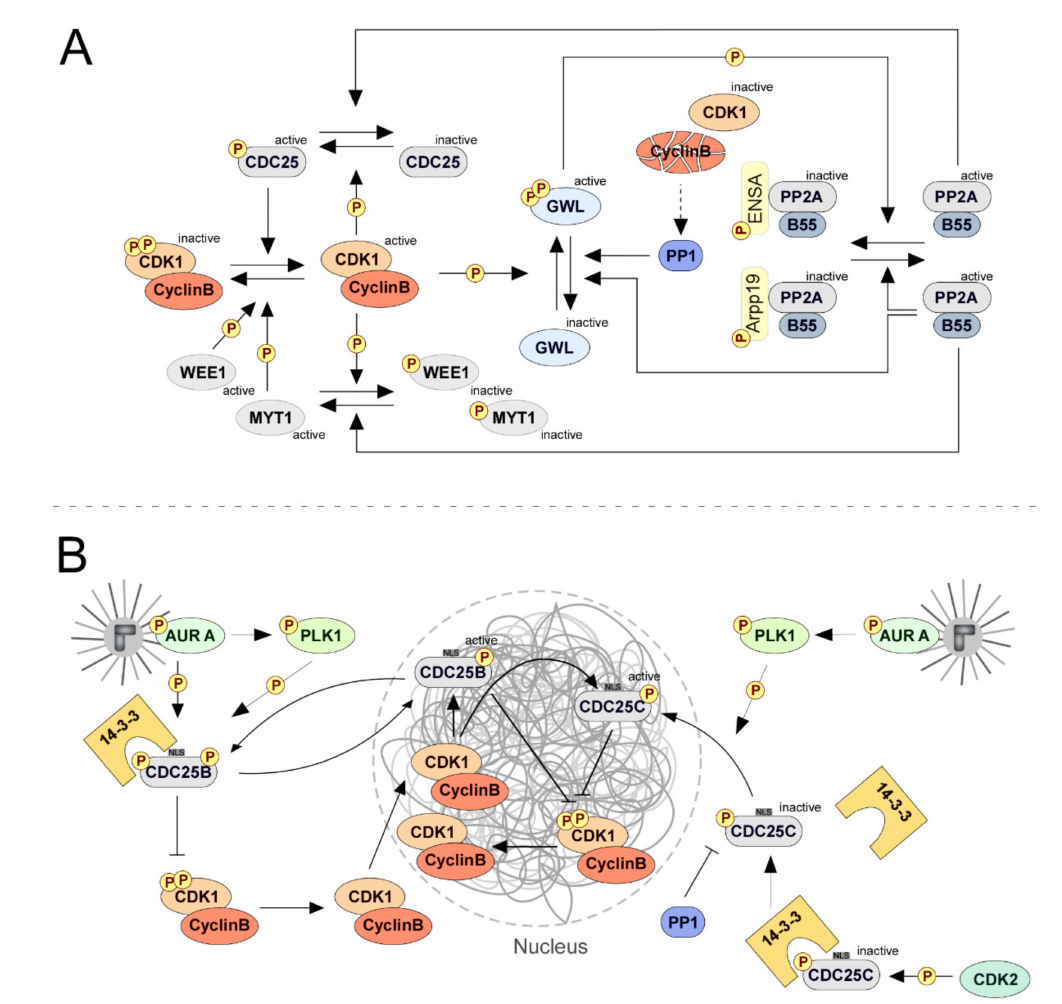
Figure 3. Molecular circuitry controlling mitotic entry. ( A ) CDC25 phosphatases dephosphorylate and activate CDK1-Cyclin B to promote mitotic entry. CDC25 activity antagonizes the inhibitory phosphorylations on CDK1 (Thr14 and Tyr15) catalyzed by MYT1 and WEE1. Active CDK1-Cyclin B respectively inhibits and promotes MYT1/WEE1 and CDC25 activities, establishing both a double negative feedback loop and a positive feedback loop. This regulatory circuitry defines a bistable trigger that ensures irreversible transition into mitosis. CDK1-Cyclin B further promotes the activation of GWL kinase, which subsequently phosphorylates ENSA and Arpp19. The phosphorylated forms of these endosulfines bind to PP2A-B55 and inhibit the phosphatase activity towards CDK1-Cyclin B substrates, including MYT1, WEE1, and CDC25. ( B ) The CDC25B and CDC25C isoforms become active during late G2 to drive CDK1-Cyclin B activation. During interphase, CDC25B and CDC25C are kept inactive by phosphorylation and are retained in the cytoplasm due to binding to 14-3-3 proteins. The activity of CDC25B is proposed to be responsible for the initial activation of CDK1-Cyclin B at centrosomes. Activation of CDC25B is triggered by Aurora A- and PLK1-dependent phosphorylations on the phosphatase N-terminus, which also promote CDC25B shuttling between the cytoplasm and the nucleus. Following activation, the centrosomal pool of CDK1-Cyclin B is translocated to the nucleus, where it enhances CDC25C activity, initiating an amplification loop that drives the cell into mitosis. The inhibitory phosphorylation on CDC25C is removed by PP1 phosphatase upon dissociation of the 14-3-3 protein. This concurs with PLK1-mediated phosphorylation of the CDC25C N-terminus to promote the phosphatase nuclear import and directly stimulate the phosphatase catalytic